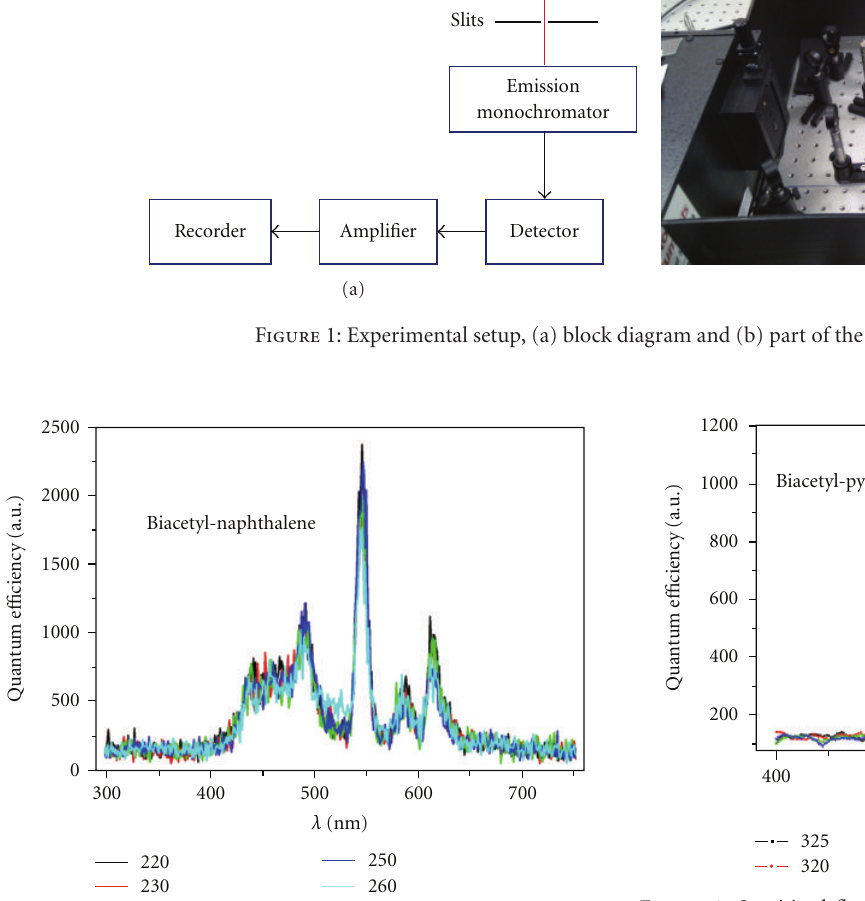
Figure 3: Sensitized fluorescence of biacetyl by pyrazine first nπ